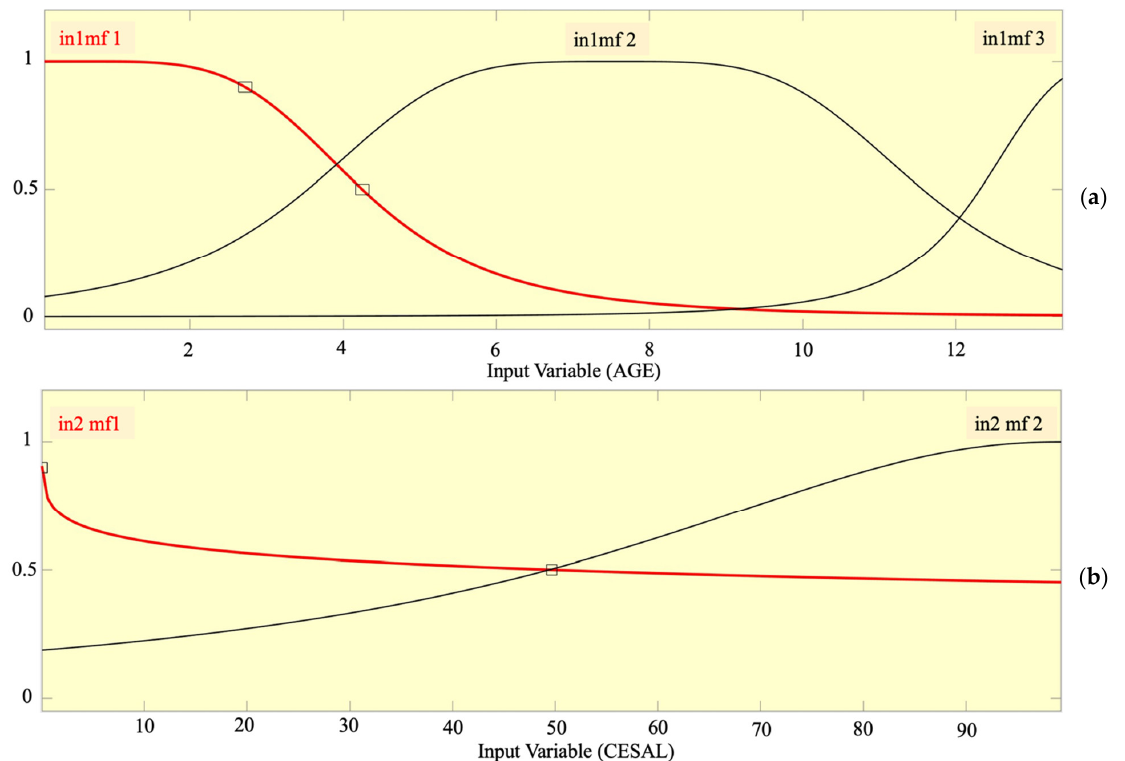
Figure 8. Final MFs for DBST input variables of ( a ) AGE and ( b ) CESAL.